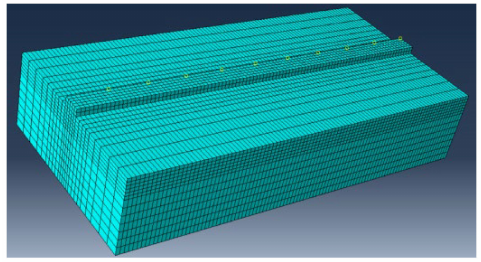
Figure 6. Finite element